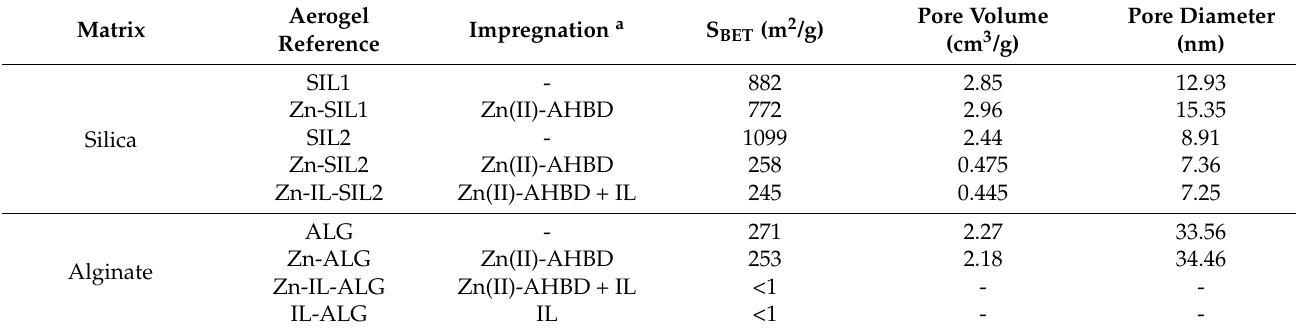
Table 2. Textural properties of blank and impregnated silica (SIL) and alginate (ALG) aerogels. Aerogels were impregnated with the zinc complex (Zn) and/or the ionic liquid [Aliquat][Cl] (IL). Matrix